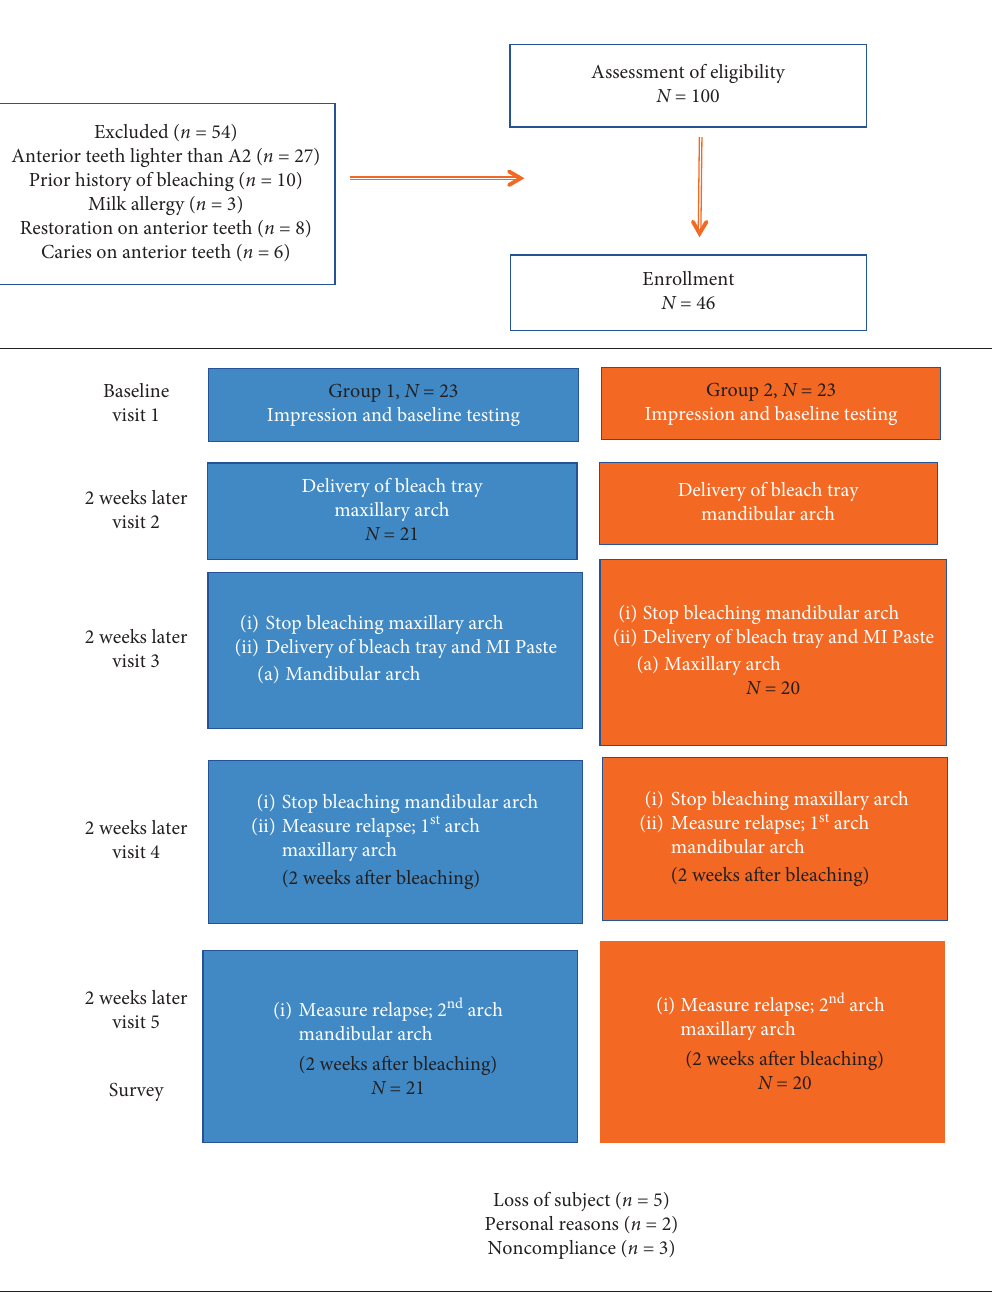
Figure 1: Description of